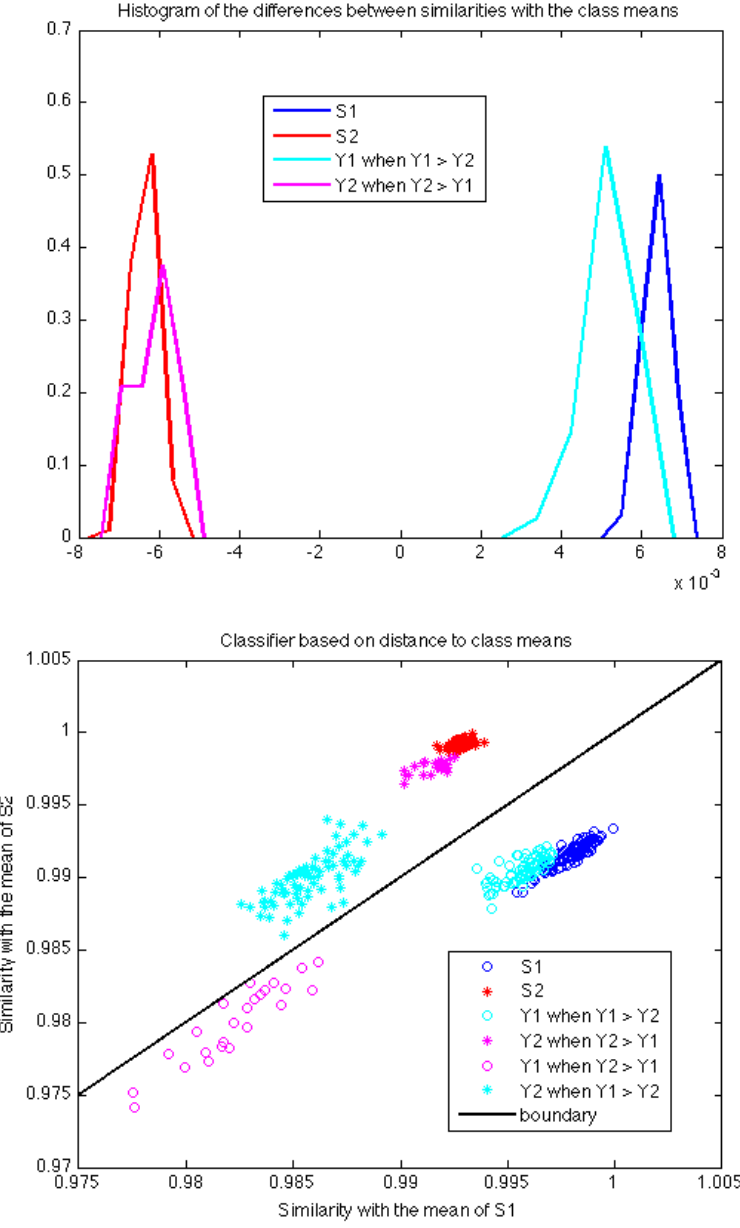
Figure 7. Results of the classification with the difference between the similarities of each sample and the mean of each class. These similarities are evaluated using the KL kernel. The top plot is a histogram of the classifier output for all the sets of samples. The bottom plot shows a scatter plot of training and test pulses in the 2D space defined by similarity to each class